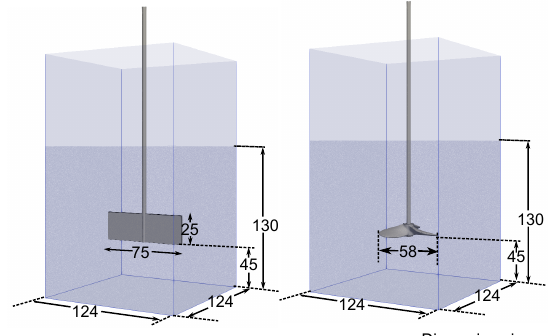
Figure 3. Experimental setup of the jar test with a radial (left) and axial (right) mixer. The dimensions are in